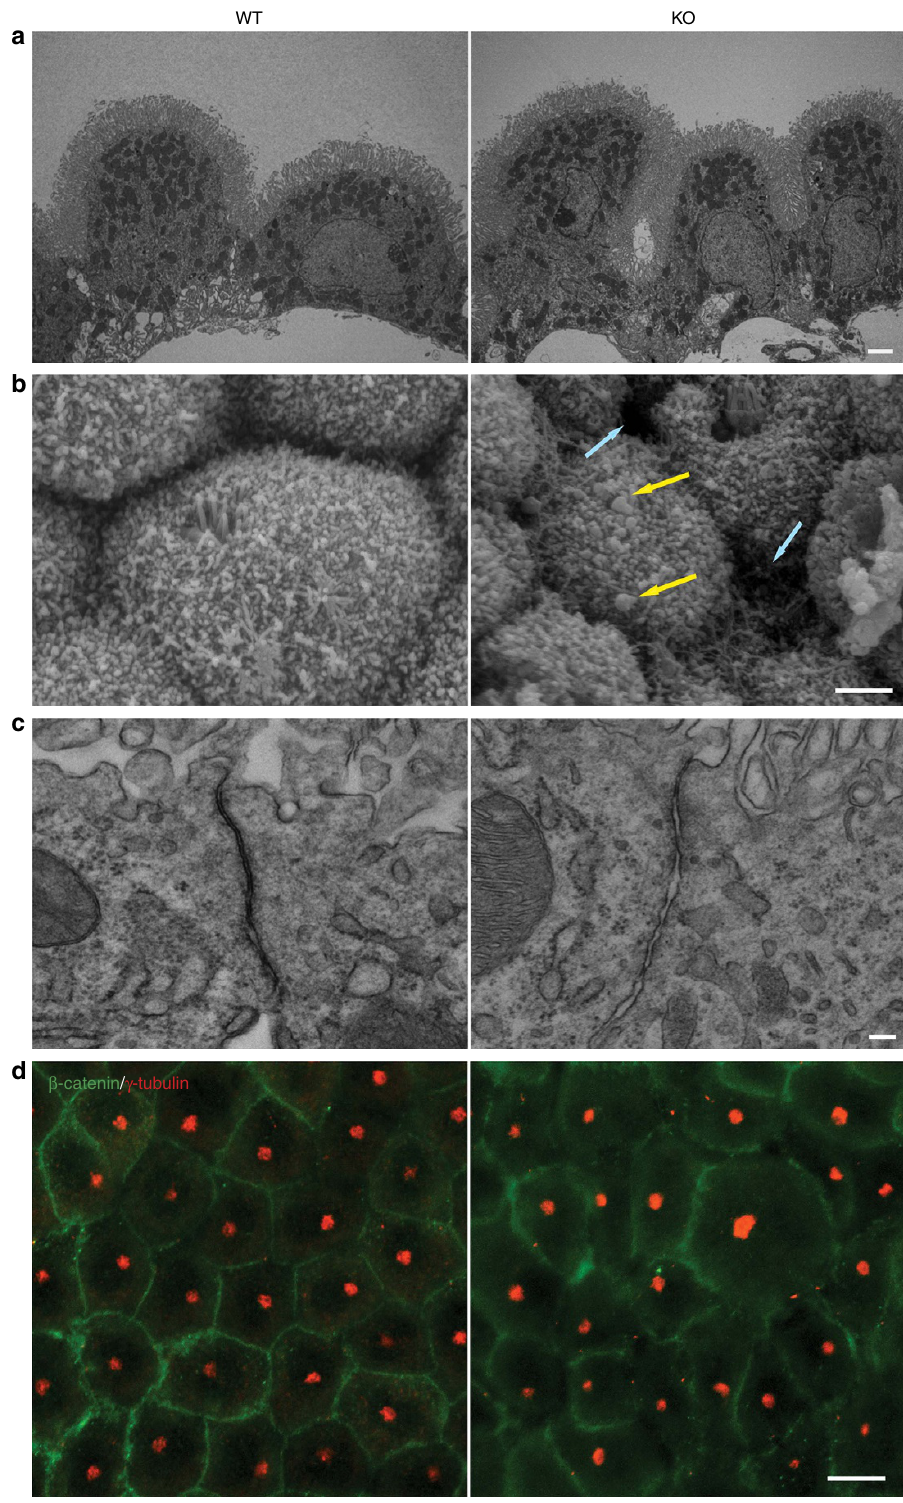
Figure 2 | Abnormal cell architecture and AJC in the Alix (cid:2) / (cid:2) CP. ( a ) transmission electron microscopy (TEM) revealed the misalignment of the epithelial cells, their irregular shape and size and the prominent blebbing of their microvilli ( n ¼ 2), Scale bar, 2 m m. ( b ) SEM of the Alix (cid:2) / (cid:2) CP apical surface showed extensive blebbing (yellow arrows) and large gaps between cells (light blue arrows) ( n ¼ 2), Scale bar, 2 m m. ( c ) High-magnification TEM abnormally distended AJC in Alix (cid:2) / (cid:2) CP ( n ¼ 3), Scale bar, 100nm. ( d ) Immunostaining of whole-mount preparations for b -catenin (green), and g –tubulin (red) demonstrated the abnormal cell shape and mislocalization of the basal bodies in the Alix (cid:2) / (cid:2) CP ( n ¼ 2). Scale bar, 10 m